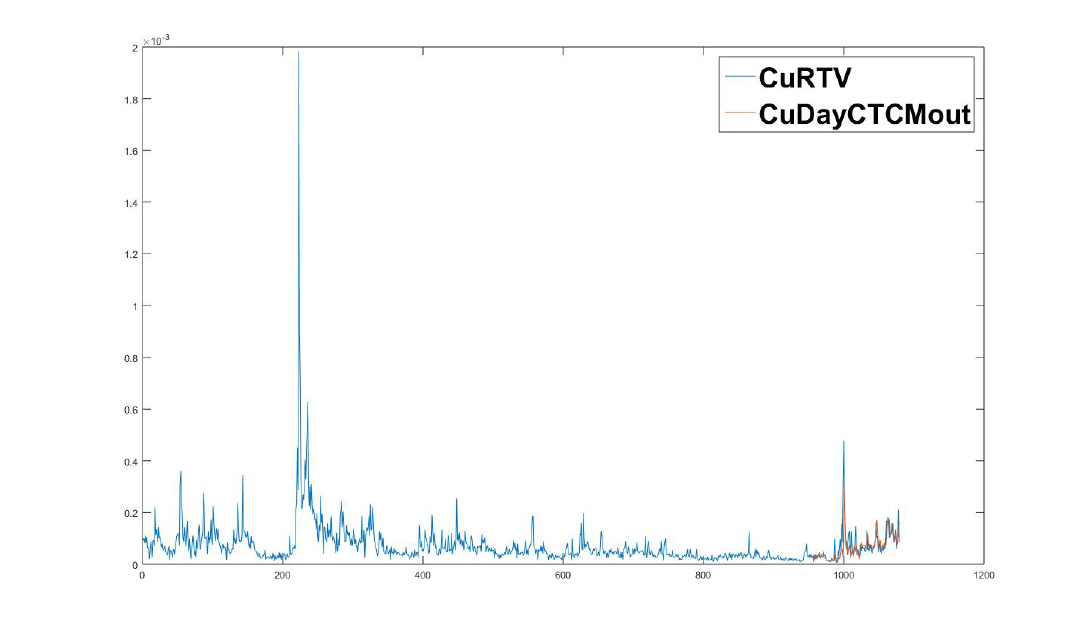
Figure 4. Model CTCM-RTV-D Forecast for Cu(SHFE). The horizontal line is the timeline, and the perpendicular line is the volatility estimator. The forecasted period is the last 124 days. The actual values are represented by the blue line, while the forecasted values are represented by the orange line. The forecasted values are closed to the actual values, although there is a sharp jump around the Day 1000.